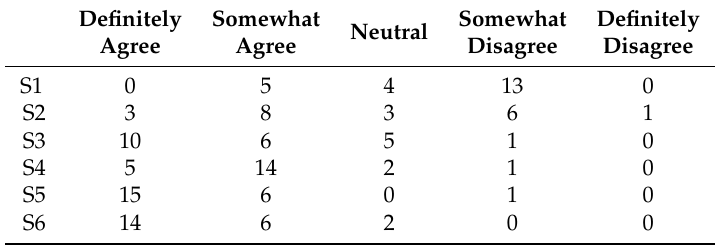
Figure 3. Task-specific questionnaire results. The participants used values 1–5 with the most negative answer mapped to 1 and the most positive answer mapped to 5. Table 4. Participants agreement on the usability of the NLI